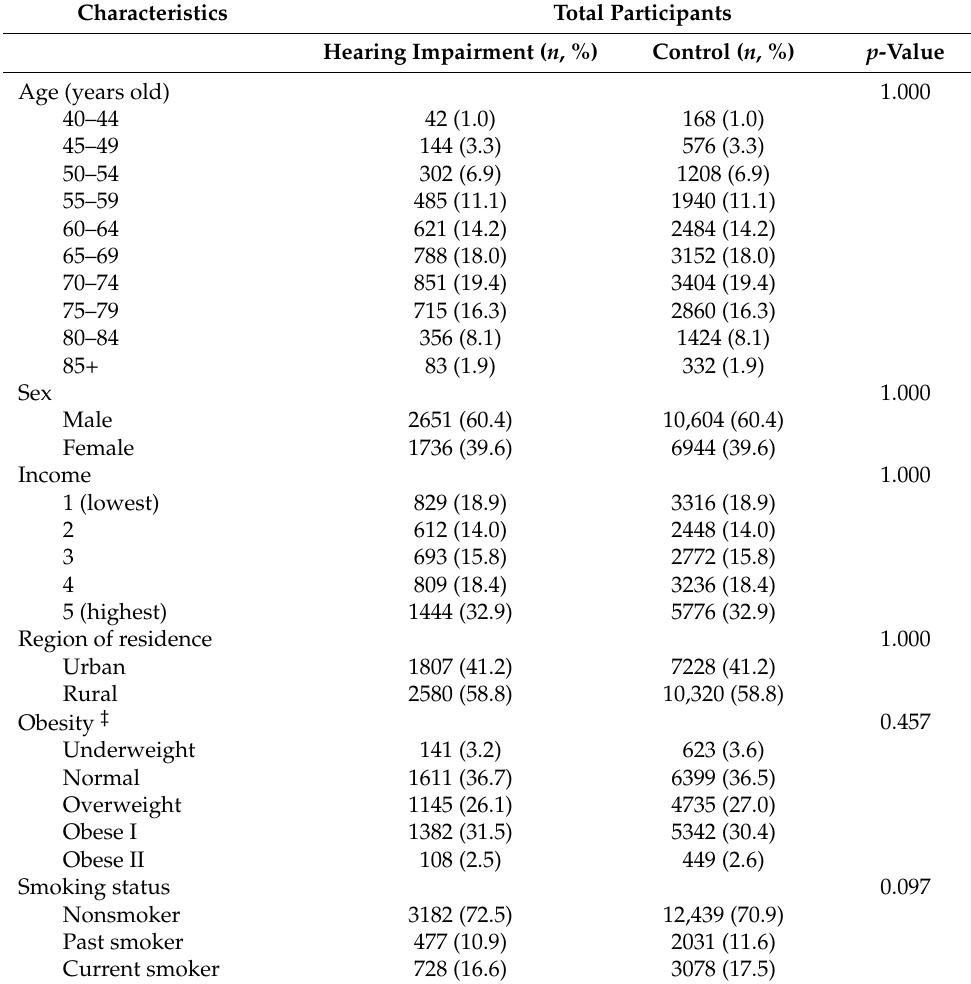
Table 1. General characteristics of